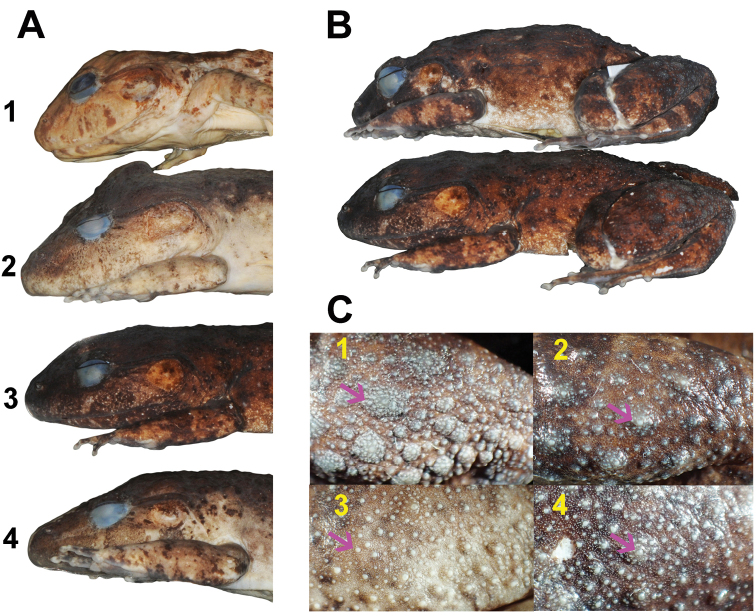
Comparisons of Limnonectesdabanus and L.savan sp. nov. in preservative A lateral view of head of males A1L.macrognathus (FMNH 174526) from Nakhon Si Thammarat Province, Thailand; A2L.dabanus (MVZ 258200) with high-profiled caruncle from Ratanakiri Province, Cambodia A3L.savan sp. nov. holotype (NCSM 76288) A4L.dabanus (MVZ 258202) with low-profiled caruncle from Ratanakiri Province, Cambodia B lateral body view of L.savan sp. nov. illustrating flank: paratype female (NCSM 76300) above; holotype male (NCSM 76288) below C dorsoposterior views of thigh illustrating tubercles (arrows) of C1L.savan sp. nov. holotype male (NCSM 76288) C2L.savan sp. nov. paratype female (NCSM 76300) C3L.dabanus male (MVZ 258200) from Ratanakiri Province, Cambodia C4L.dabanus female (MVZ 258235) from Ratanakiri Province, Cambodia.